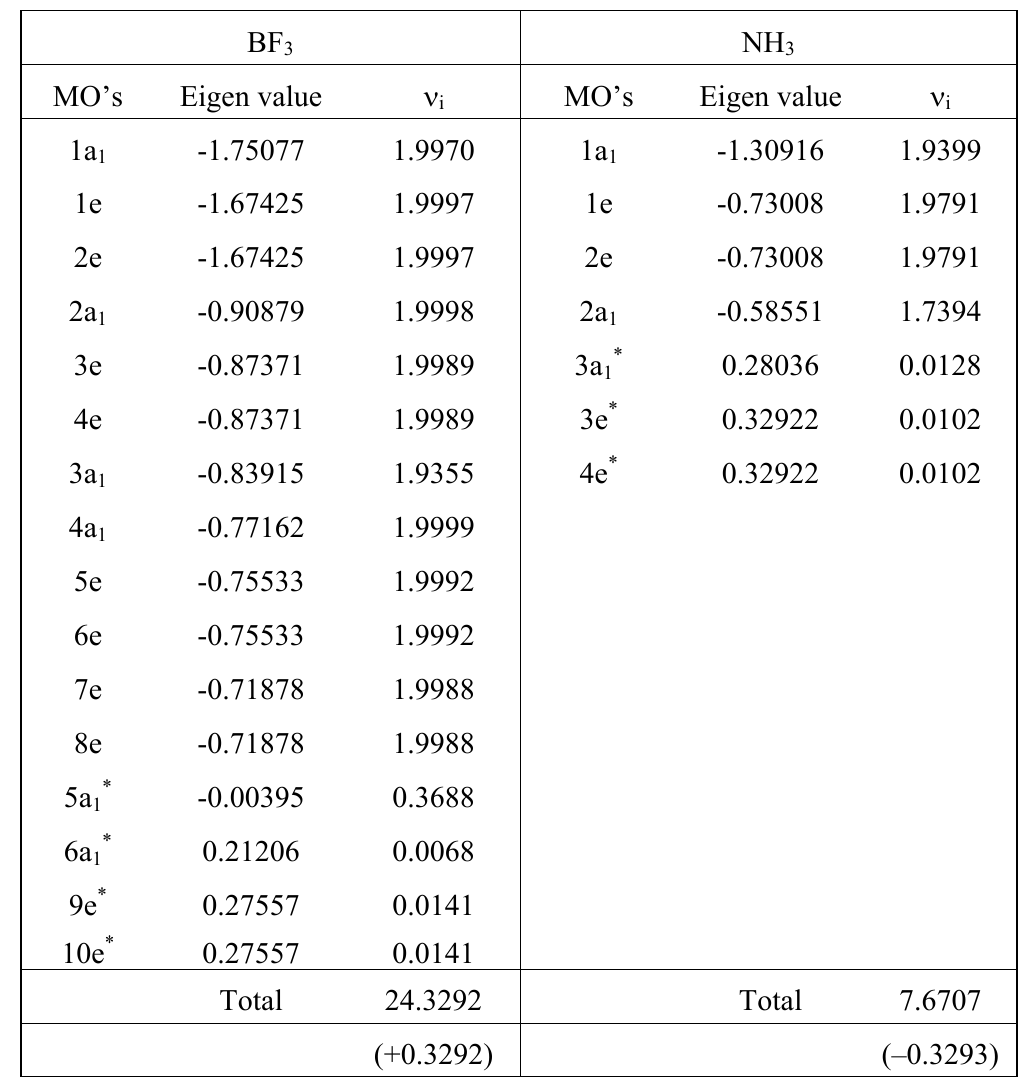
Table 4. Occupation Numbers ( ν fragments and amount of net transfer of charge due to their interaction